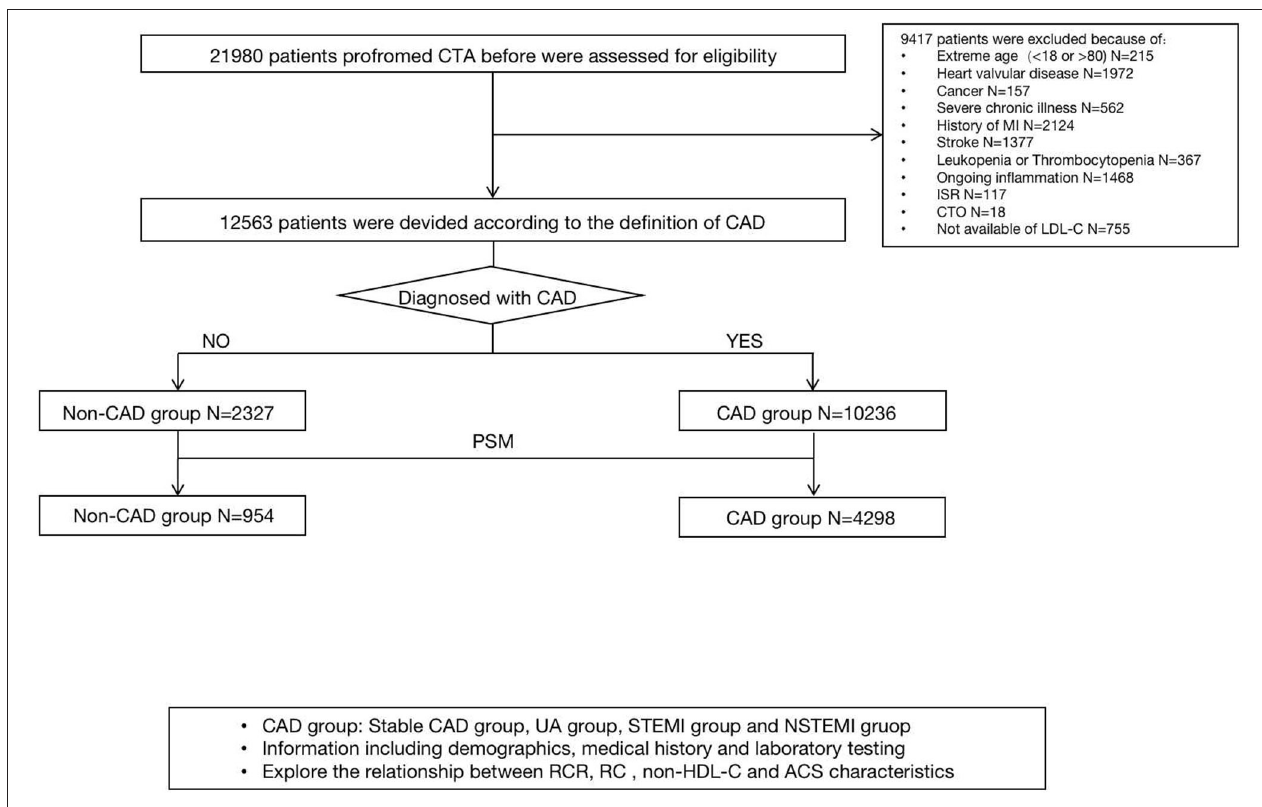
FIGURE 1 | A study flowchart of